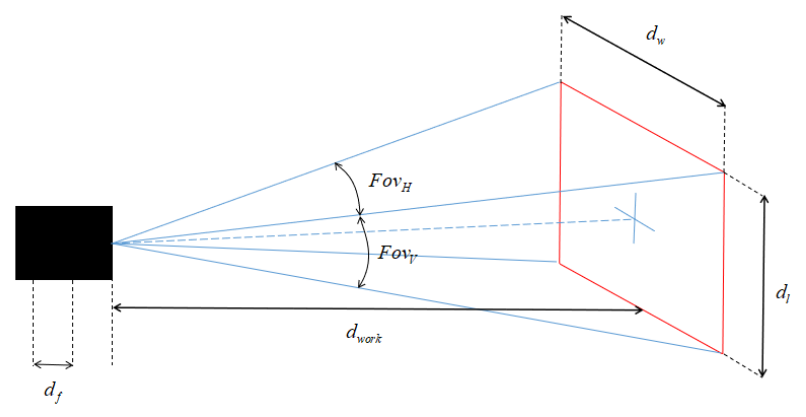
Figure 3. Schematic diagram of the camera model and parameters.